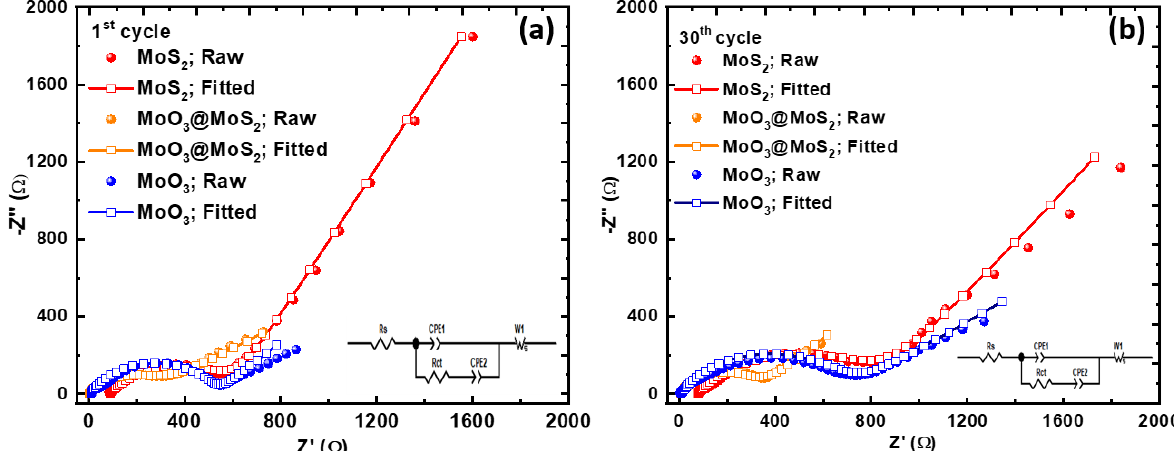
Figure 7. EIS profiles of MoS 2 , MoO 3 @MoS 2 , and MoO 3 ( a ) after the 1st cycle, and ( b ) after the 30th cycle.